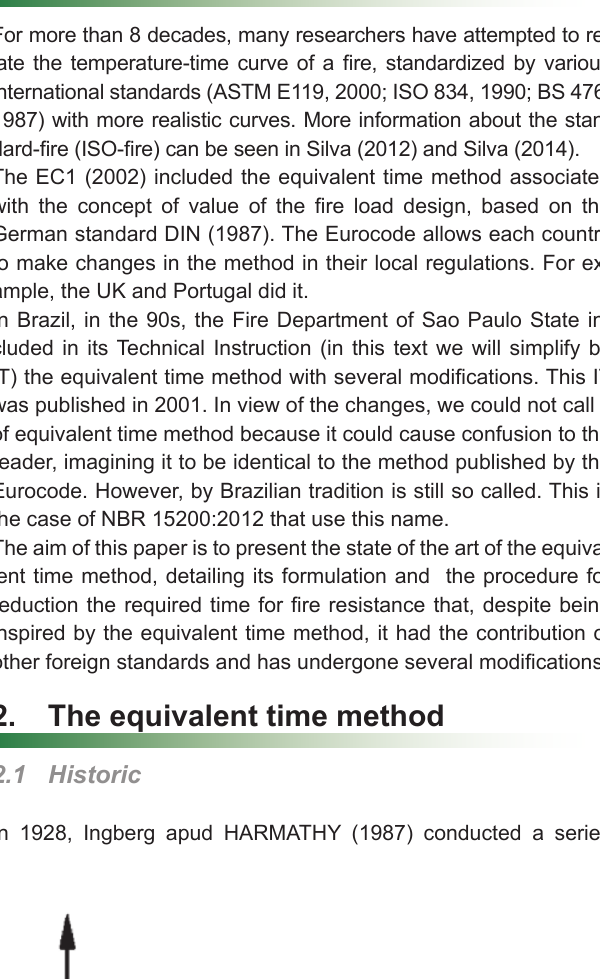
Relationship between the fire load and